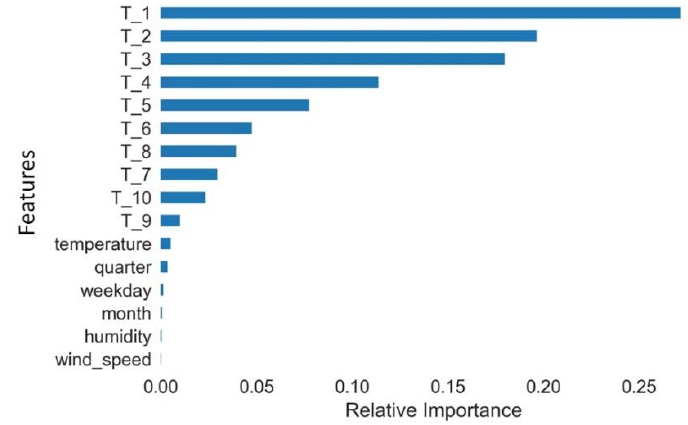
Figure 8 . Feature importance plot. Figure 8. Feature importance